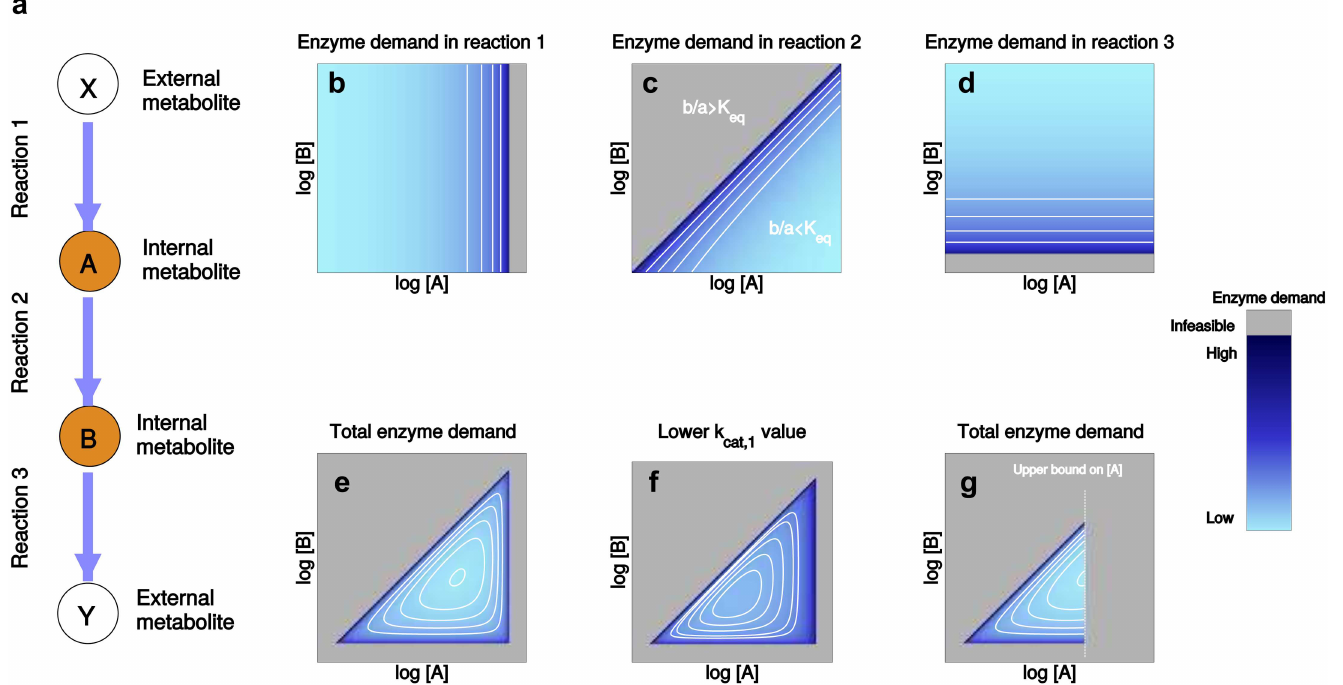
Fig 2. Enzyme demand in a metabolic pathway. (a) Pathway with reversibleMichaelis-Menten kinetics (equilibrium constants, catalytic constants, and K M values are set to values of 1, [A] and [B] denote the variableconcentrations of intermediates A and B in mM). The external metabolitelevels [X] and [Y] are fixed. Plots (b)-(d) show the enzyme demand of reactions 1, 2, and 3 at given flux v = 1 accordingto Eq (2). Grey regions represent infeasible metabolite profiles. At the edges of the feasible region (where A and B are close to chemical equilibrium), the thermodynamic driving force goes to zero. Since small forces must be compensatedby high enzyme levels, edges of the feasible region are always dark blue. For example, in reaction 1 (panel (b)), enzyme demand increaseswith the level of A (x-axis) and goes to infinity as the mass-action ratio [ A ]/[ X ] approaches the equilibrium constant (where the driving force vanishes). (e) Total enzyme demand, obtainedby summing all enzyme levels. The metabolitepolytope—the intersection of feasible regionsfor all reactions—is a triangle, and enzyme demand is a convex function on this triangle. The point of minimum total enzyme demand defines the optimal metabolitelevels and optimal enzyme levels. (f) As the k cat value of the first reaction is lowered by a factor of 5, states close to the triangleedge of reaction 1 become more expensive and the optimum point is shifted away from the edge. (g) The same model with a physiological upper bound on the concentration [A]. The bound defines a new triangleedge. Since this edge is not caused by thermodynamics, it can contain an optimum point, in which drivingforces are far from zero and enzyme costs are kept